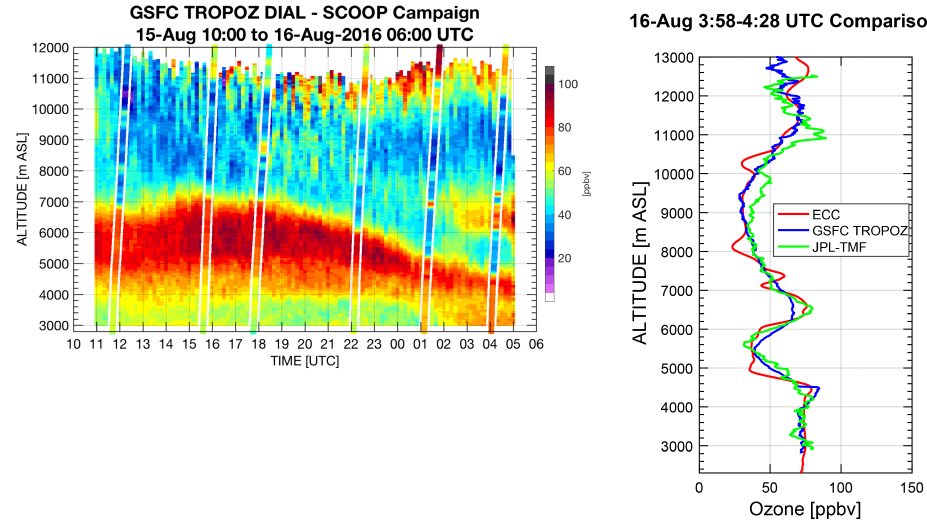
Figure 8. (a) Time series of 10min GSFC TROPOZ lidar observations during the SCOOP campaign at JPL Table Mountain Facility (site elevation: 2300ma.s.l.) along with six ECC sondes (denoted by triangles). (b) Comparison of 30min averaged ozone from GSFC TROPOZ and JPL-TMF ozone lidars as compared to the last sounding of the time series. Courtesy: John T. Sullivan, NASA/GSFC.